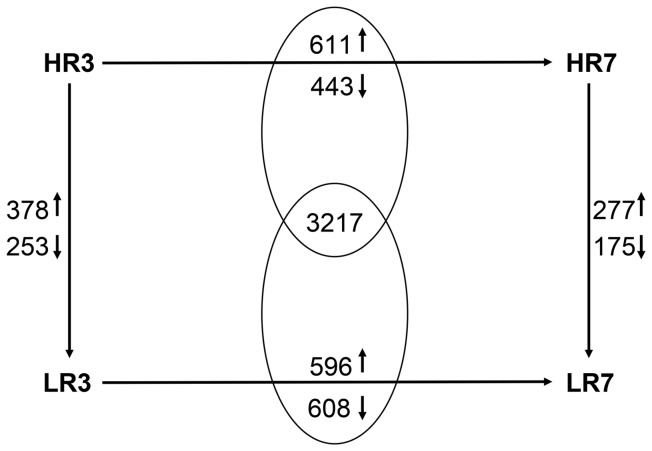
Number of regulated probe-sets in the endometrial biopsies.The numbers at the horizontal arrows indicate the quantity of probe-sets significantly regulated between the adjacent stages within either the HR or the LR group, whereas the numbers in the intersections indicate the quantity of probe-sets commonly regulated between day 3 to day 7 (↑ = higher transcript abundance at day 3, ↓ = lower transcript abundance at day 3) in both the HR and the LR group. The numbers at vertical arrows are the number of probe-sets differentially expressed between HR and LR at the same day of estrous cycle (↑ = higher transcript abundance in the HR groups, ↓ = lower transcript abundance in the HR groups).